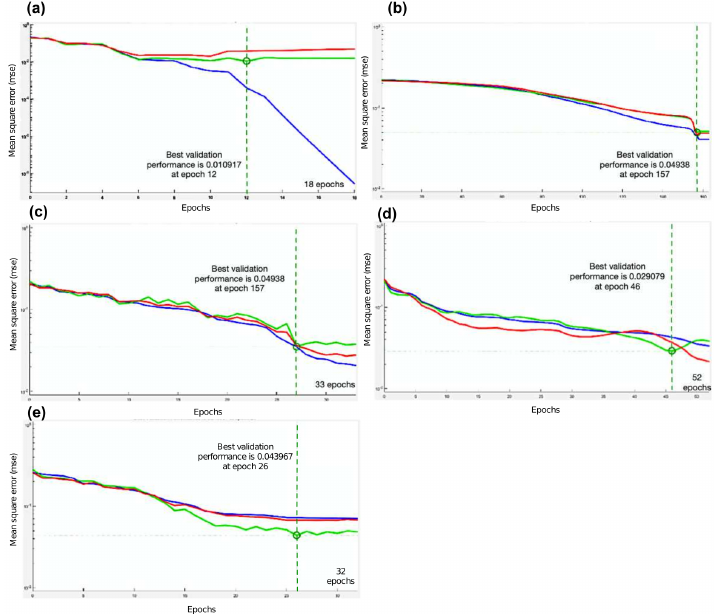
Figure 18. Evaluated TF’s performance where blue line is the training, green line the validation, red line the test, and dot line the best validation performance for 5 case studies: ( a ) Trainlm, ( b ) Trainbfg, ( c ) Traingcp, ( d ) Trainoss and ( e ) Traingdx.